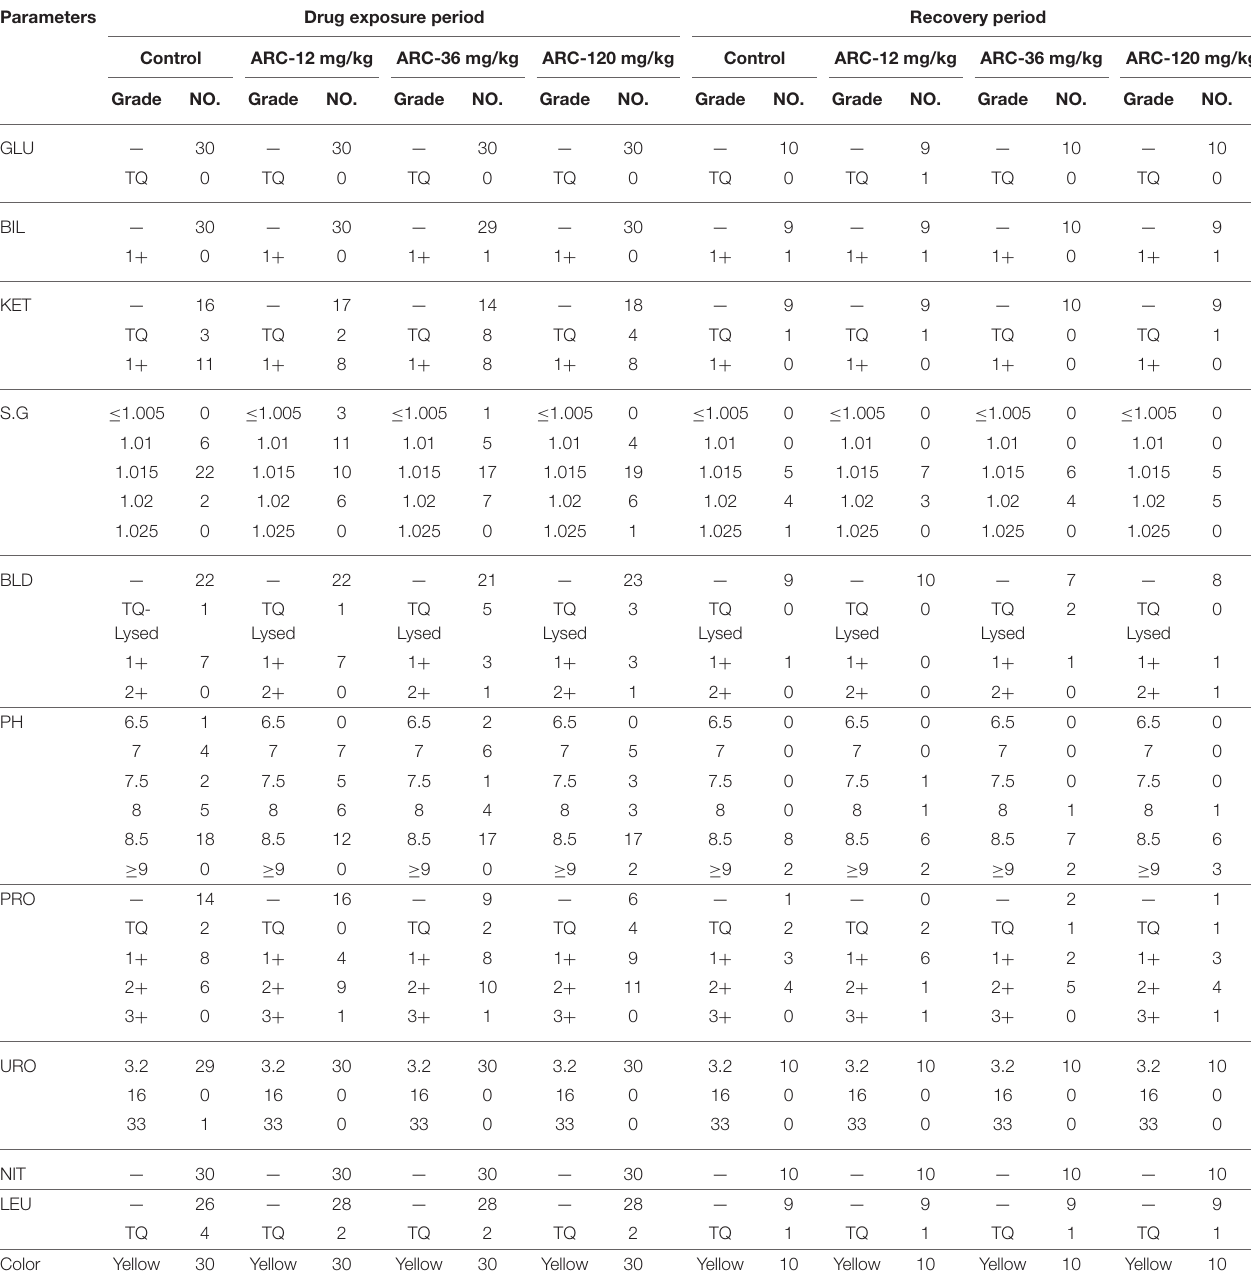
TABLE 1 | The urine examination paremeters of Arctigenin (12-, 36-, and 120 mg/kg) administration by gavage (i.g) in rats during drug exposure period ( n = 30, 15 female, 15 male) and recovery period.